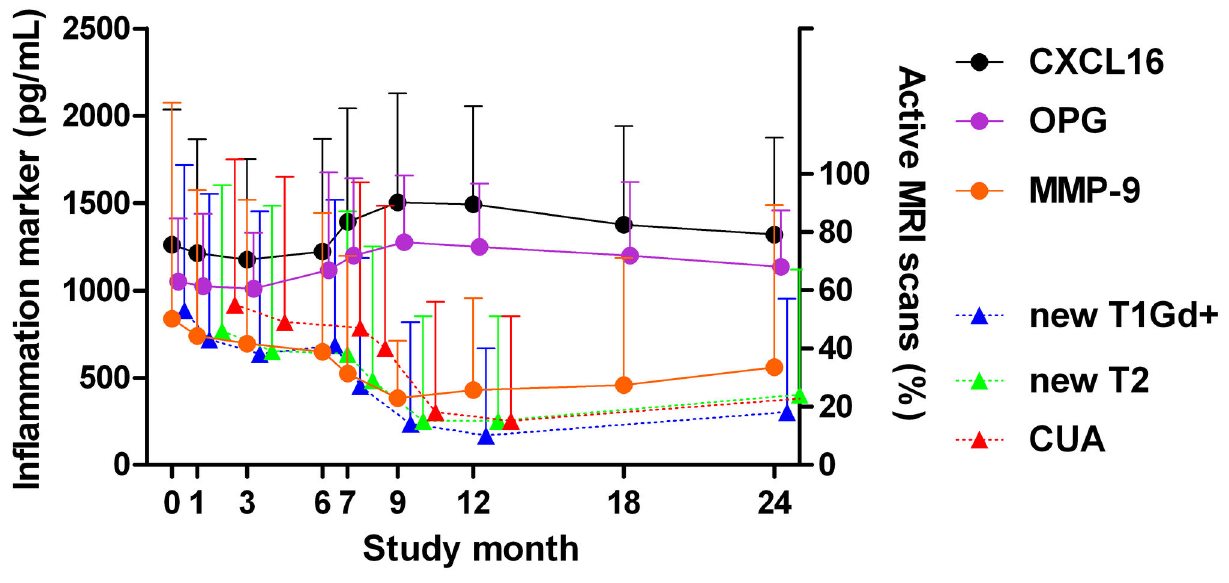
Figure 1. MRI activity and mean concentrations (positive SD) of inflammation markers significantly associated with MRI outcomes throughout the study. All available observations at each time point are included (see Table S1 for numbers). All T1Gd + lesions are shown at month 0 (baseline). Abbreviations: CXCL16: Chemokine (C-X-C motif) ligand 16, OPG: osteoprotegerin, MMP-9: matrix metalloproteinase 9, T1Gd + : gadolinium enhancing T1 MRI lesion, CUA: combined unique activity.